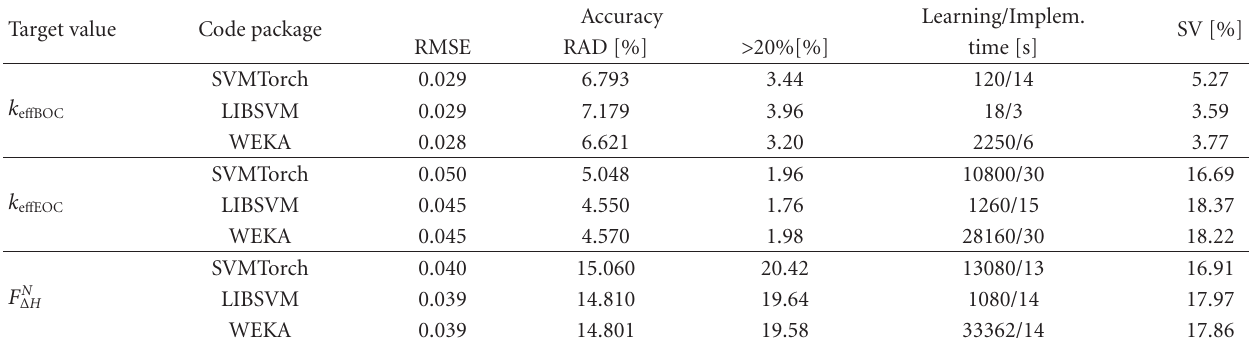
Table 1: Comparison of results for RBF kernel function.